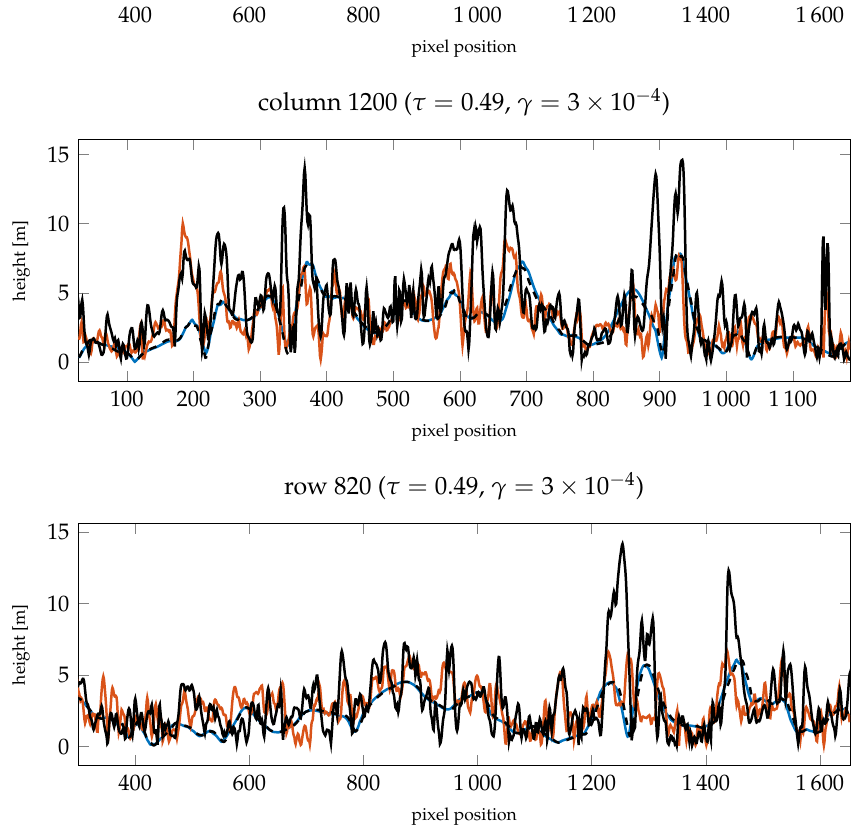
Figure A4. Slopes for image K13_058554_2232_XN_43N103W (medium atmospheric conditions) not displayed in the main